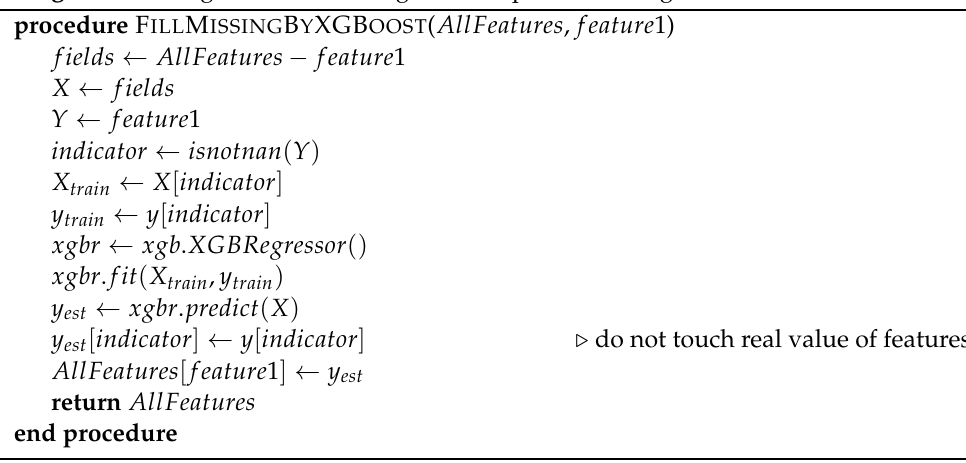
Algorithm 1: Algorithm of missing value imputation using XGBoost procedure F ILL M ISSING B Y XGB OOST ( AllFeatures , f eature